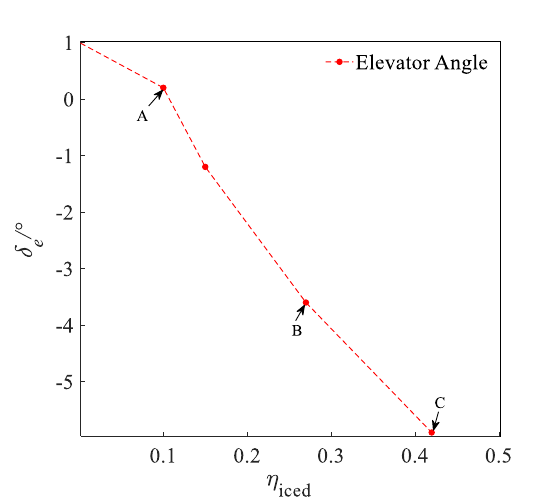
Figure 14. Balancing value of elevator